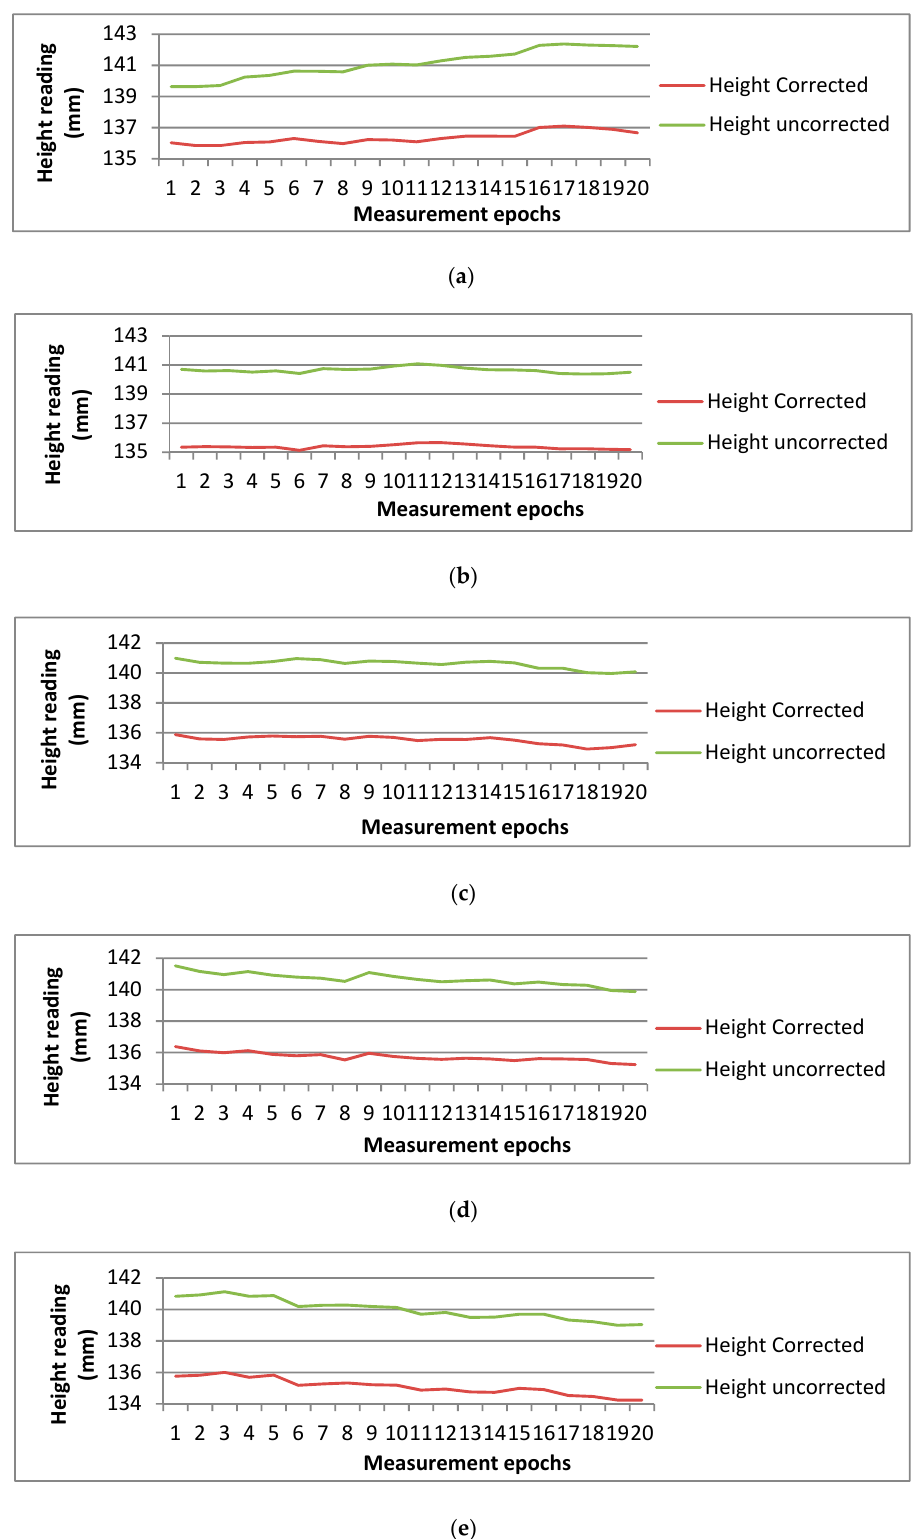
Figure 15. The variation trends of the 20 reading results of the five data sets, ( a ) Data set 1 which corresponds to 30 degrees; ( b ) Data set 2 which corresponds to 60 degrees; ( c ) Data set 3 which corresponds to 120 degrees; ( d ) Data set 4 which corresponds to 120 degrees; ( e ) Data set 5 which corresponds to 150 degrees. Table 6. Height reading stability analysis when the camera lens is rotatable.